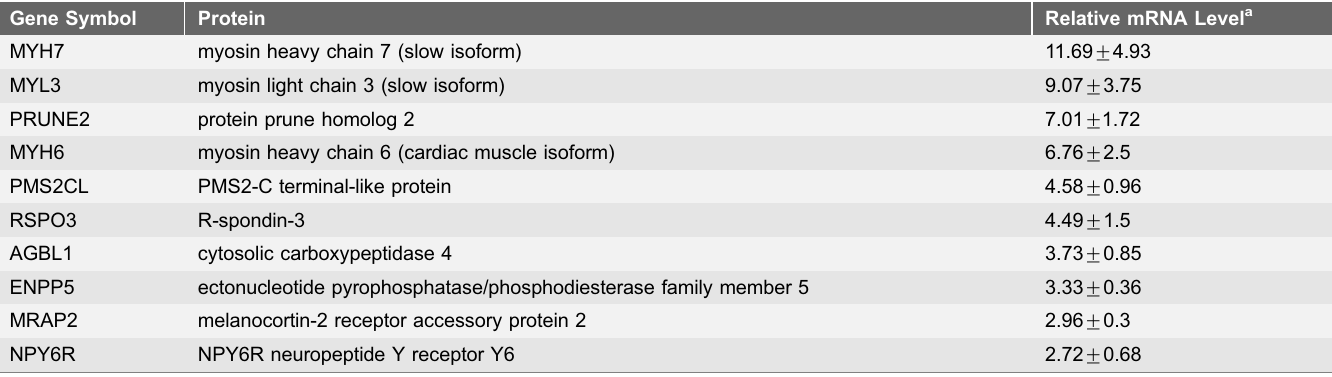
Table 2. Top 10 Expressed mRNA Gene Transcripts Following Chronic Training of Electrical Muscle Stimulation. Gene